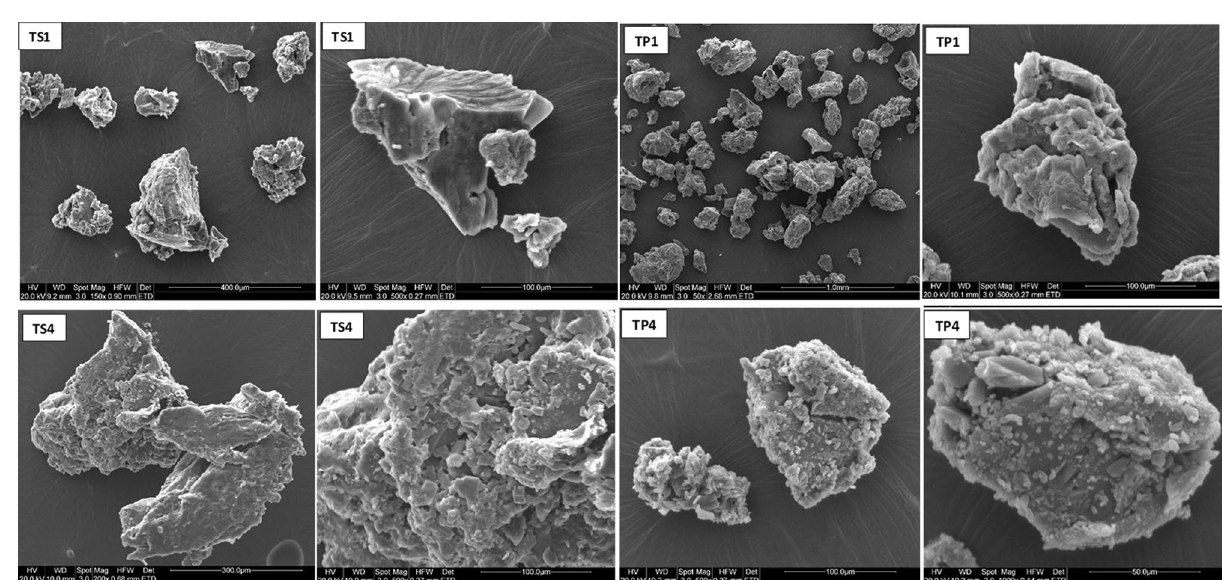
Figure 8. SEM images of TS1, TS4, TP1 and TP4 particles. TS1 and TP1 display smooth surface and no presence of PCT crystal is observed. However, PCT crystals can be observed on the surface of TS4 and TP4